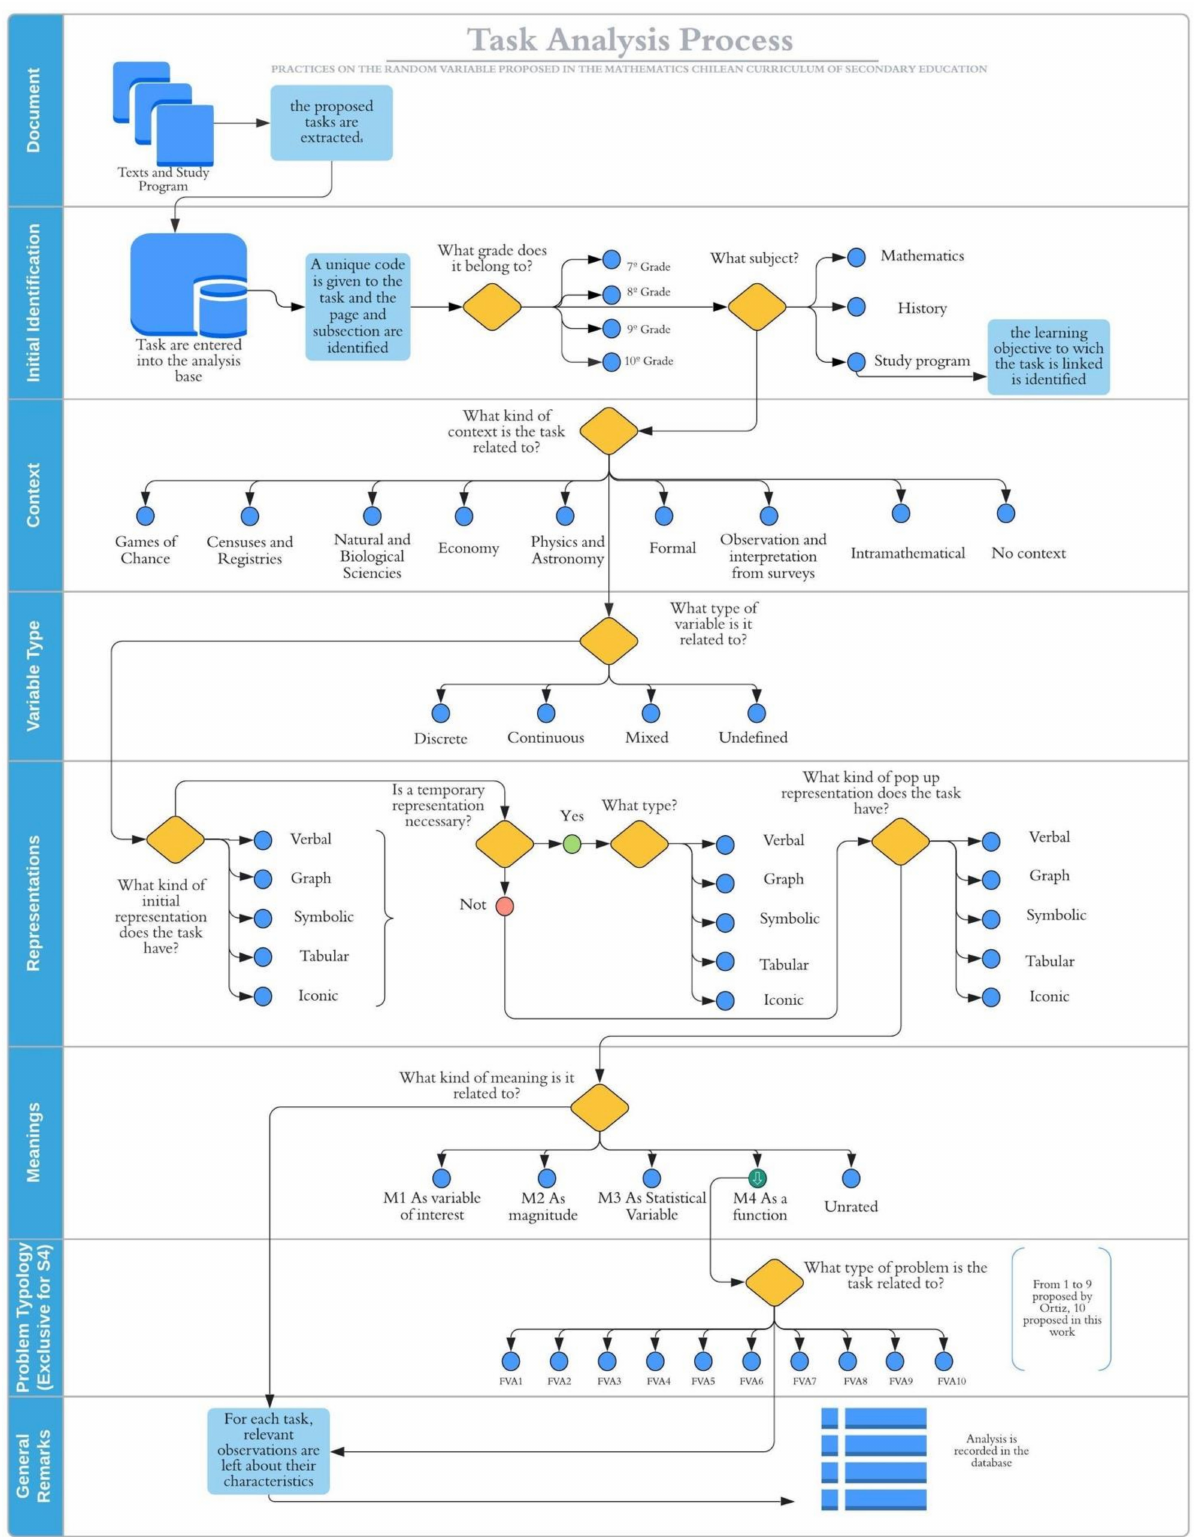
Figure 2. Process of task/problem analysis (Source: Prepared by the